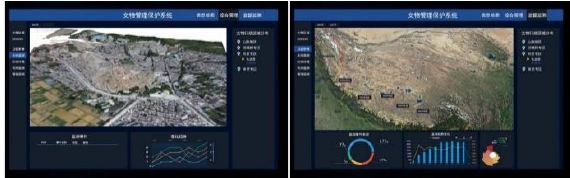
Figure 3. Cultural heritage preservation and management information platform of Tibet Autonomous Region